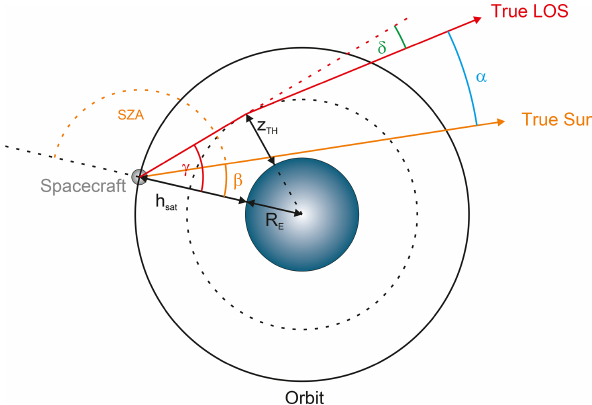
Figure 4. Definition of angles and other quantities used in the re- fraction